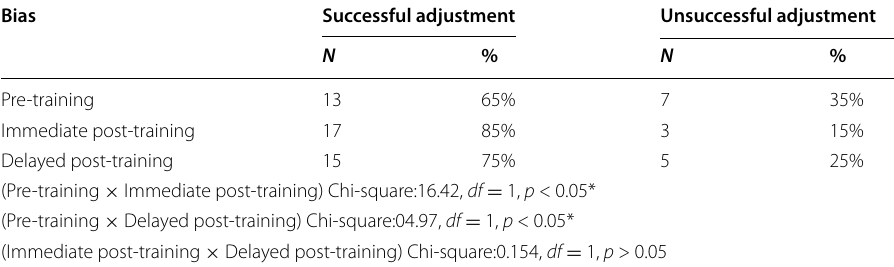
Table 9 Effectiveness of training program and feedback provision on raters’ bias measures